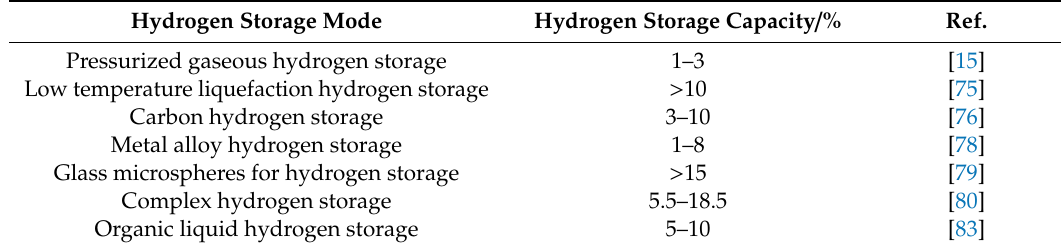
Table 1. Hydrogen storage capacity of di ff erent hydrogen storage